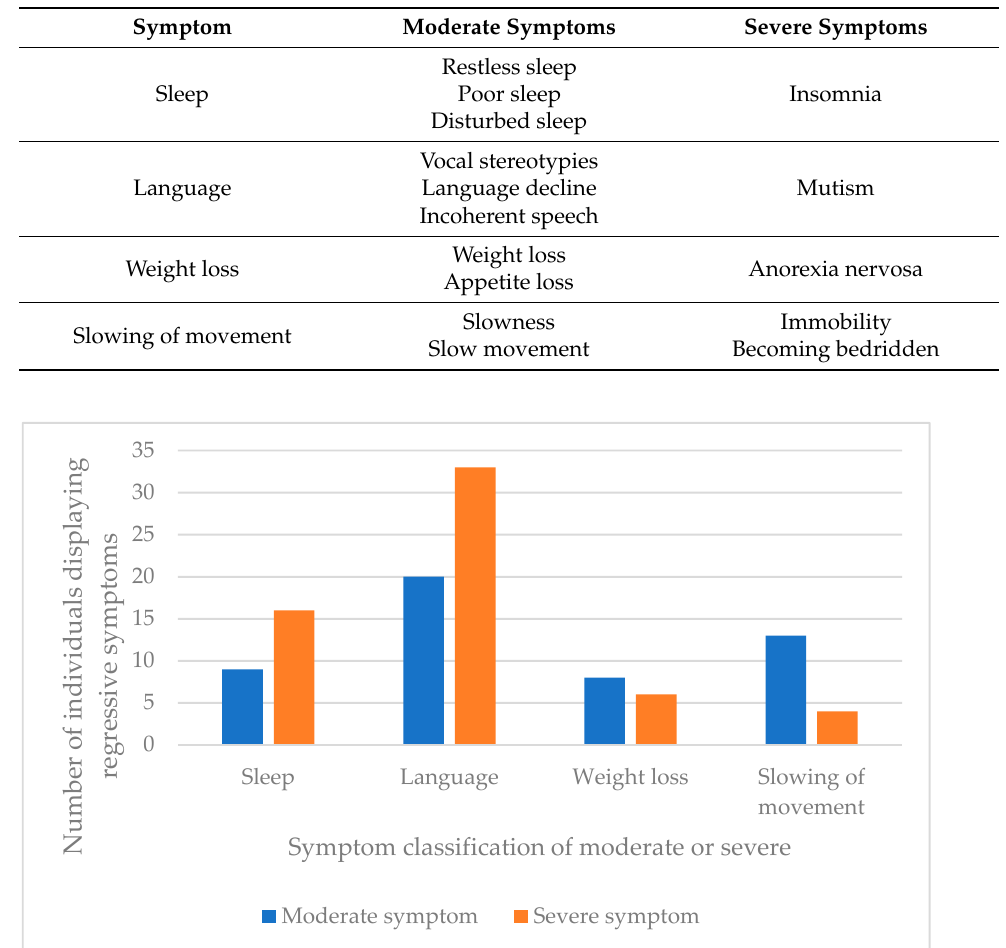
Figure 3. Number of case study patients (Group A, n = 39) where further details were given on the severity of the symptom.